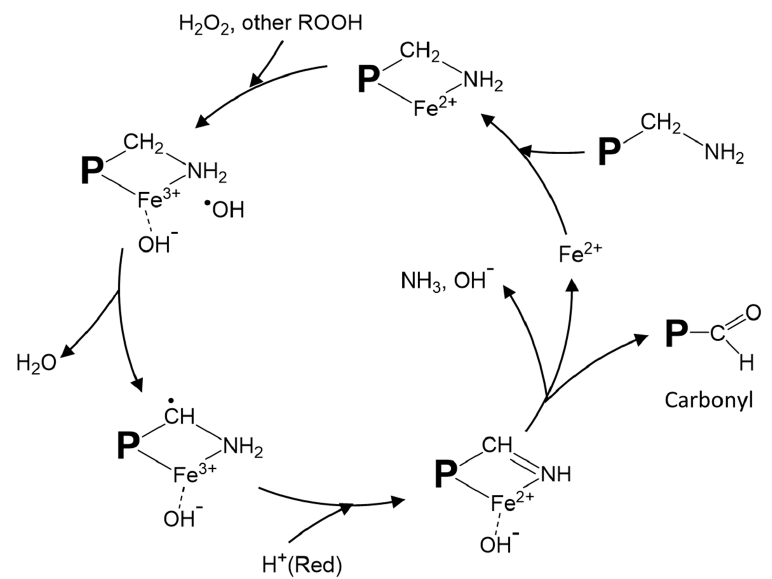
Figure 1. Proposed site-specific metal-catalyzed oxidation of protein amino acid residues. The illustration shows iron-catalyzed radical formation and carbonyl generation from oxidized lysine residues. A modified drawing from [51]. P: protein; ROOH: peroxide; Red: reducing compound. In describing ROS-induced amino acid side chain modification, Statdman and Berlett Table 2. Oxidation of protein amino acid residue side chains and exemplary [53] presented the relative reactivity of different amino acids. Virtually all amino acid